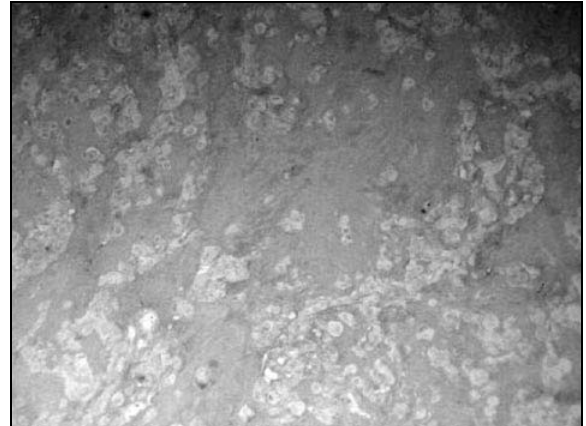
Figura 5 – Predomínio do componente mesenquimal no centro da lesão (Alcian blue pH 2,5,